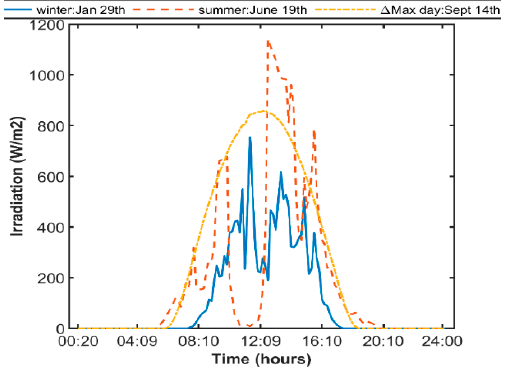
Figure 10. Irradiation profiles for winter, summer and ∆ Max days.